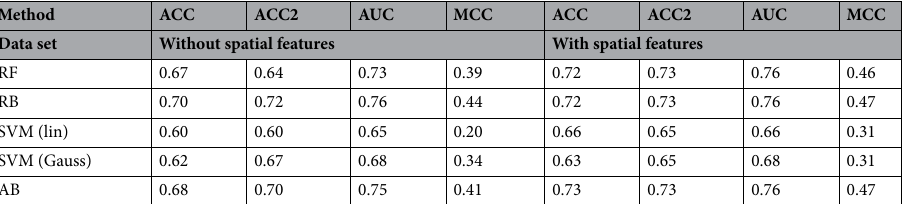
Table 2. Classification results of the tested classifiers for 25 mice with LOOS for the multispectral data set without (left side) and with spatial (right side) features. The PCA is done and 99% of the variance of the PCA is